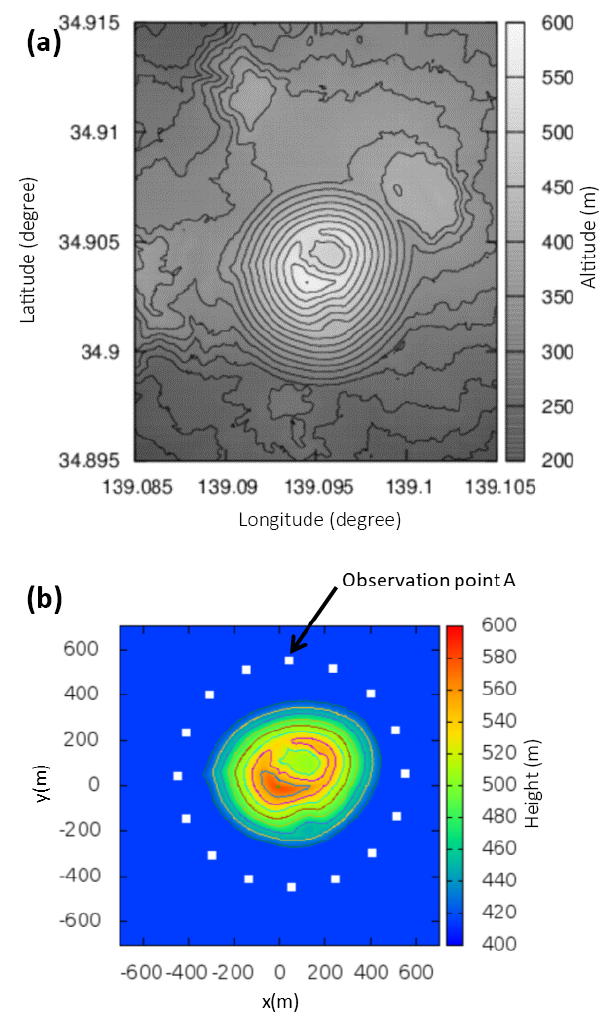
Figure 3. (a) Omuroyama digital elevation model (DEM) data from the Geospatial Information Authority of Japan. (b) The mountain body model and observation points (when the number of observa- tion points is 16). Based on the Omuroyama digital elevation model (DEM) data from the Geospatial Information Authority of Japan. All areas with altitudes of 420m or less are adjusted to an altitude of 420m. The resolution is 5m. The coordinate origin is at the sum- mit (34.903056 ◦ N, 139.094444 ◦ E). Observation points are located on the circumference with a radius of 500m centered on a point that was moved x = 50m and y = 50m from the summit.